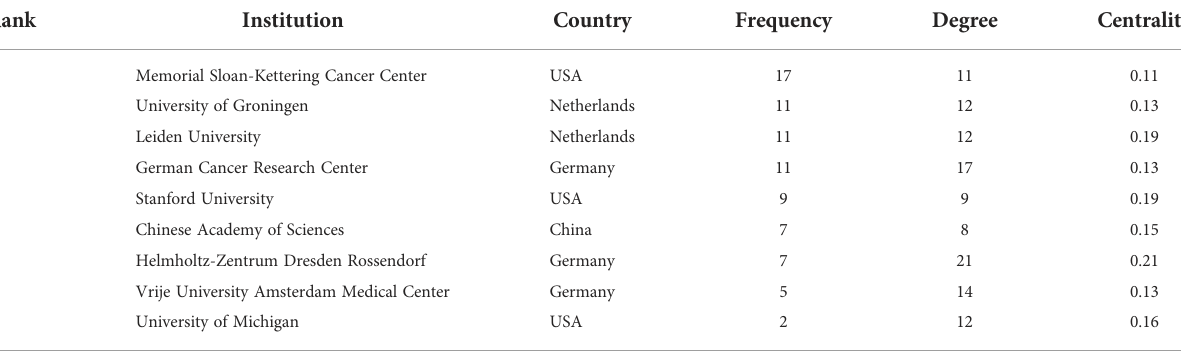
TABLE 1 Institutions with the highest frequency related to 18 F-FDG PET/CT radiomics.